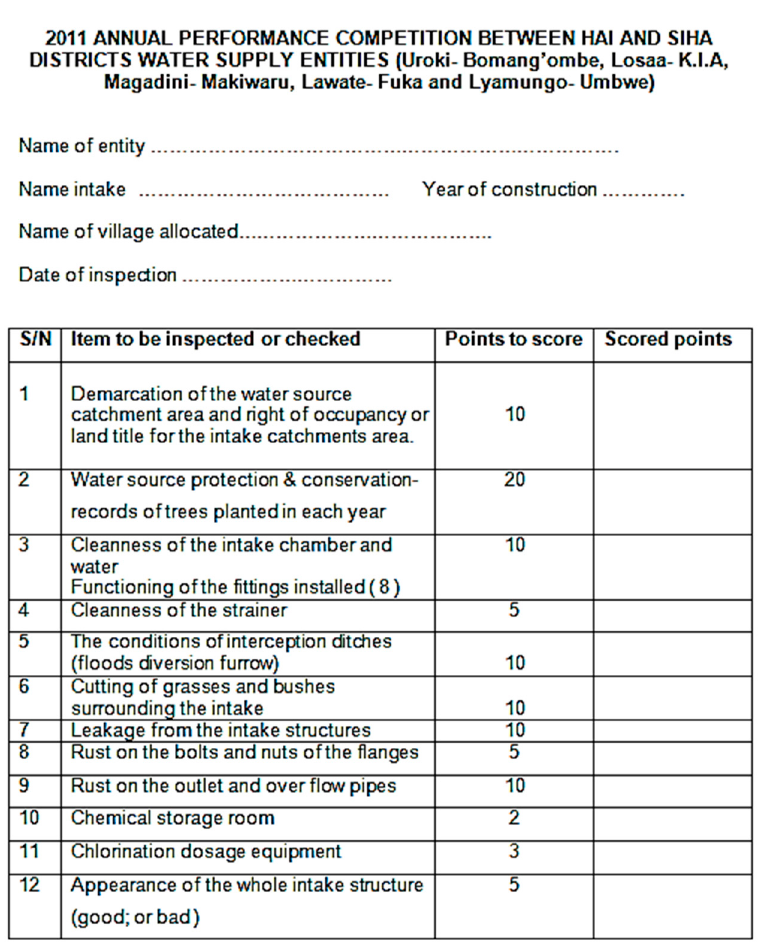
Figure 4. Appraisal form used to evaluate the WTs [37].